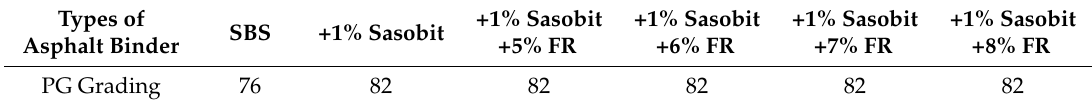
Table 8. Summary of performance graded (PG) grading